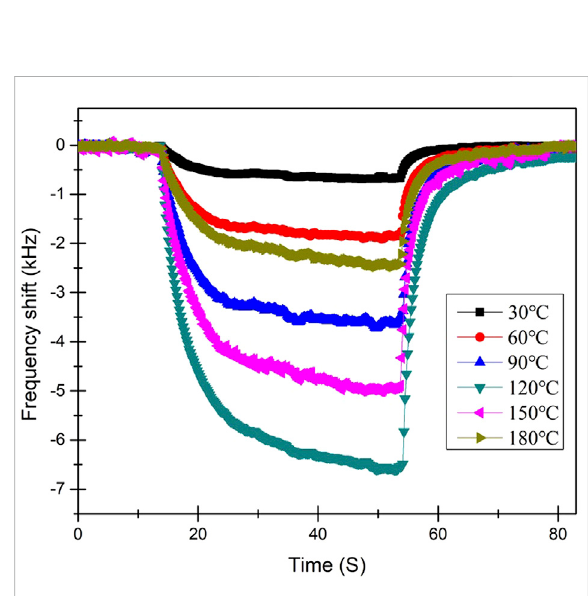
FIGURE 5 Sensor responses toward 4.0 ppm formaldehyde for the sample with fi lm thickness of 2.2 μ m at different